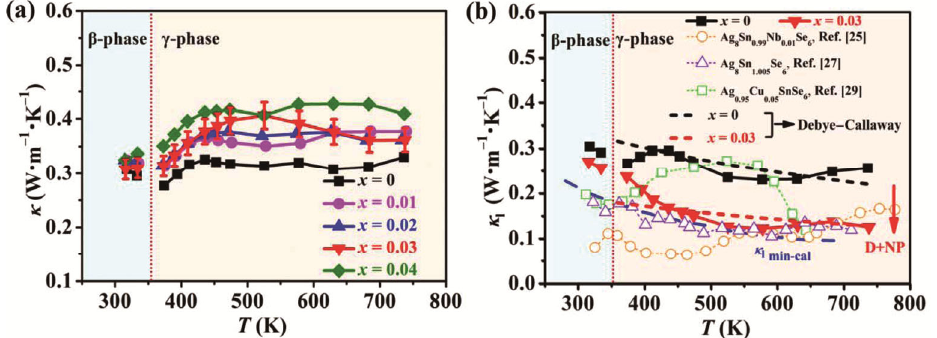
Fig. 5 Temperature dependence of the thermal transport property for Ag 8 Sn 1+ x Se 6 − 2 x Br 2 x ( x = 0, 0.01, 0.02, 0.03, and 0.04): (a) κ and (b) κ l . D and NP in (b) represent the dislocation and nanoprecipitate, respectively ( κ l min-cal is calculated based on the model proposed by